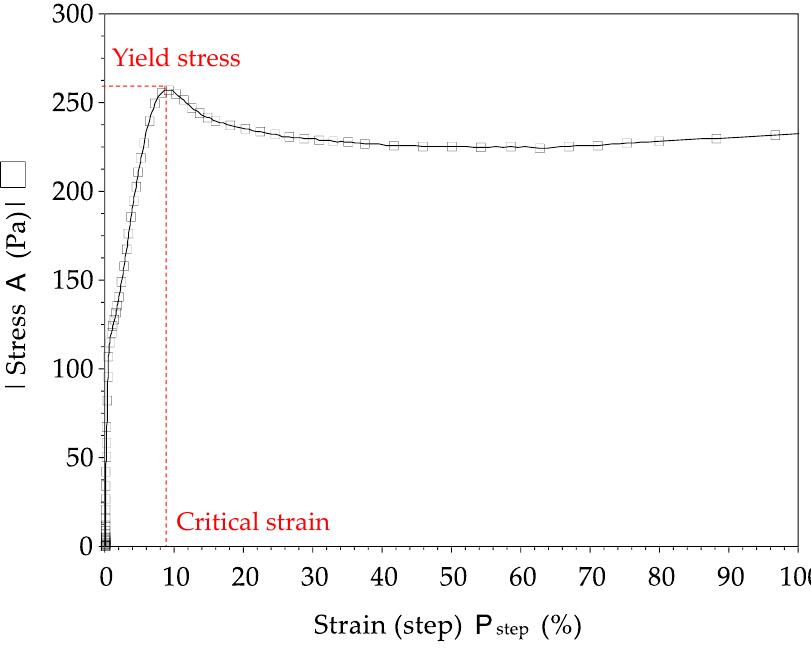
Figure 2. Typical evolution of shear stress under a low constant shear rate.